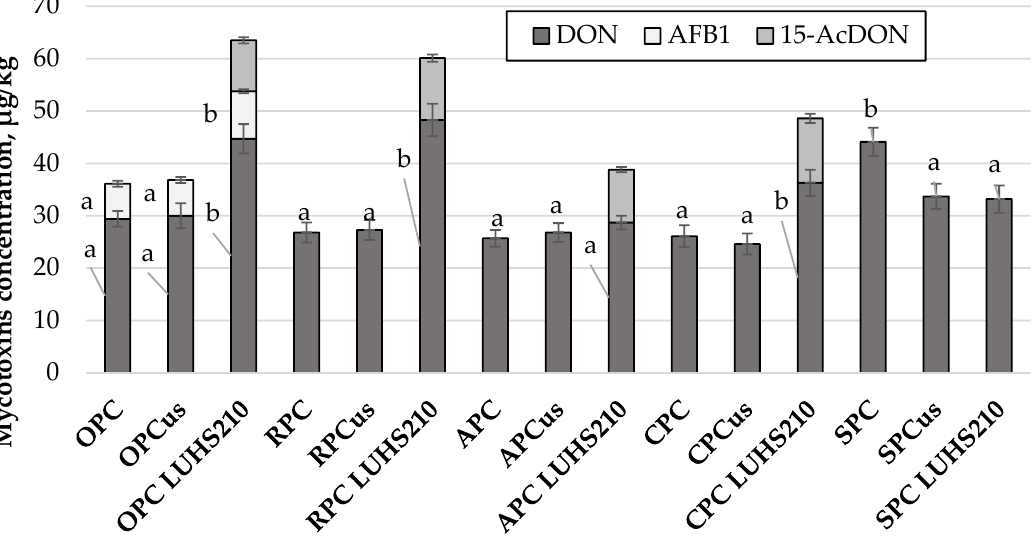
Figure 1. Mycotoxins concentration (µg/kg) in ultrasound treated and fermented with LUHS210 strain byproducts. Data are represented as means ( n = 3) ± SD. a – b Means with different letters for same byproduct group are significantly different ( p < 0.05). RPC — rice press cake; SPC — soy press cake;